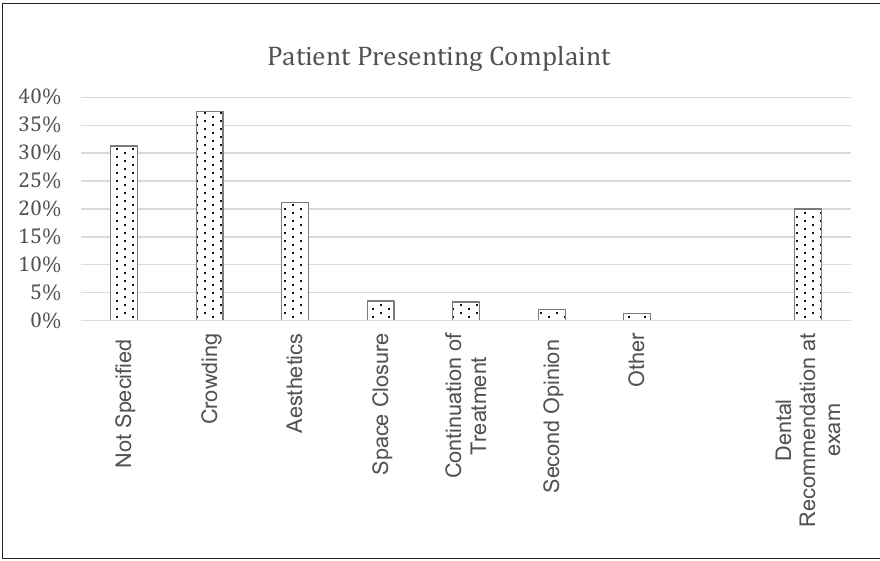
Figure 1. Age distribution showing the proportion of each gender within an arbitrary selected age range. Figure 1.